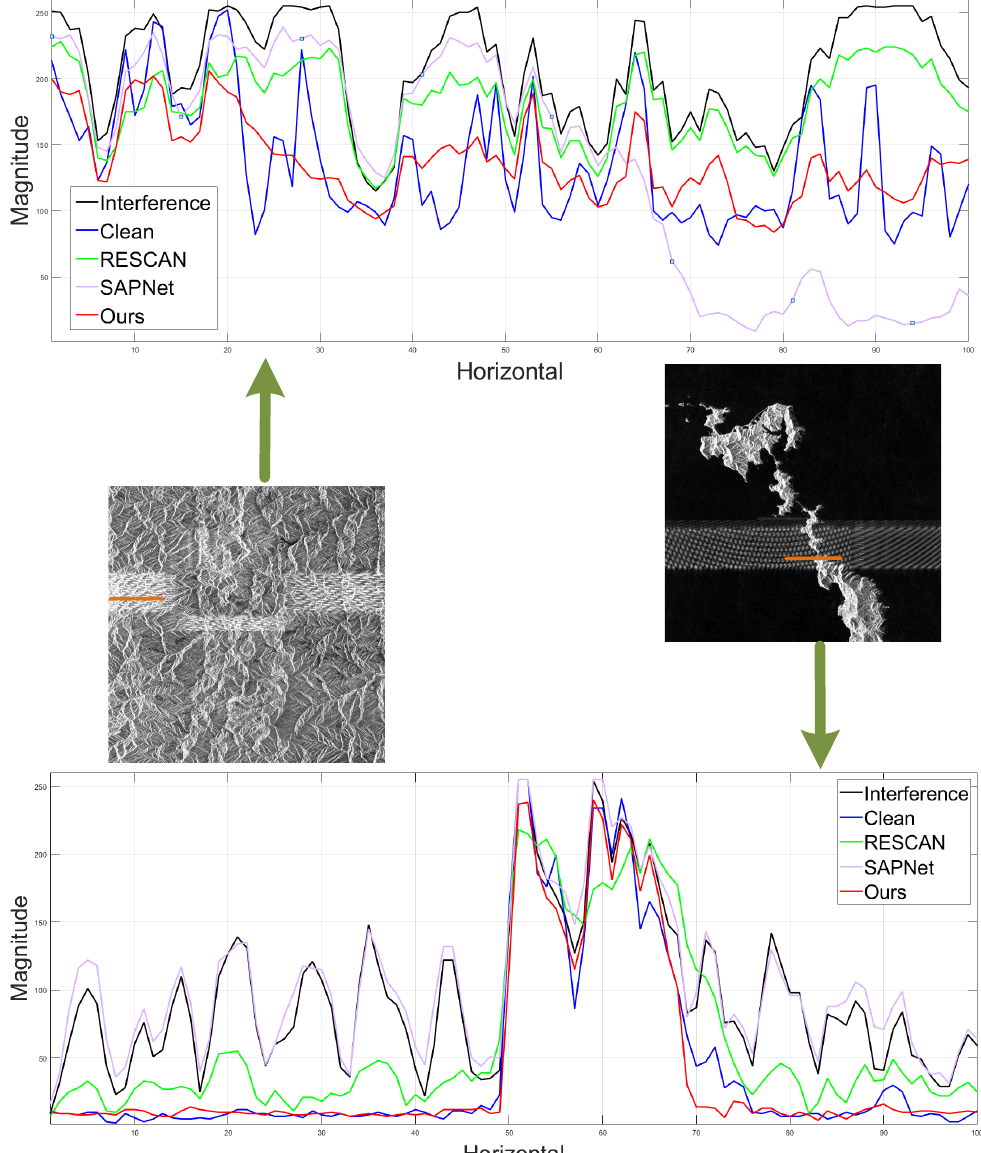
Figure 12. Scattering characteristics analysis. Where the orange horizontal line indicates the gray- value profile. The red curves indicate the scattering analysis of our results. The blue curves indicate the scattering analysis of the clean